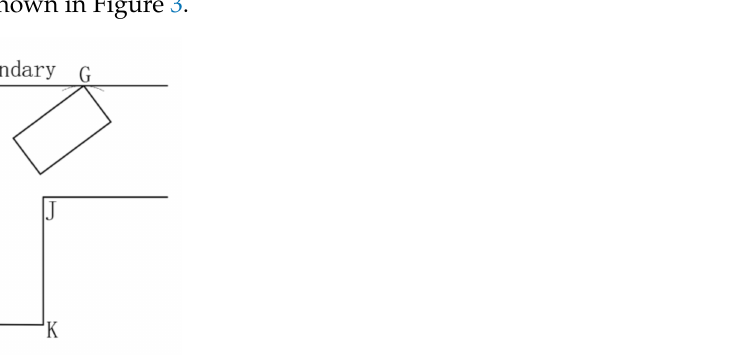
Figure 3. Schematic diagram of the collision between the G point at the head and lane